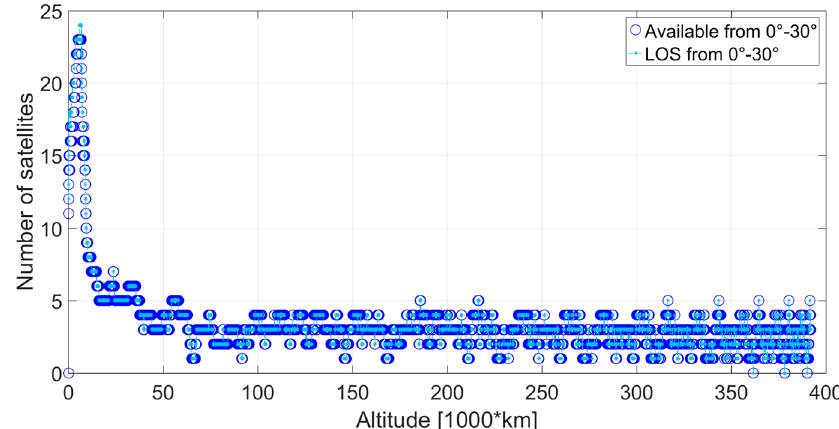
Figure 37. Visible satellites (in the line of sight (LOS)) and available satellites at the receiver’s position, for which the corresponding signal is transmitted at an angle between 0° and 30° from the transmitter’s boresight.